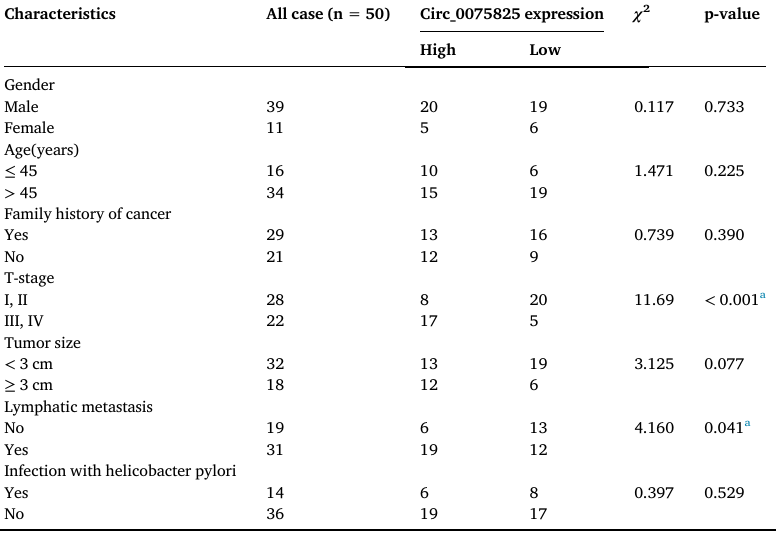
Table 2 Association between circ_0075825 expression and clinicopathological characteristics of GC patients.